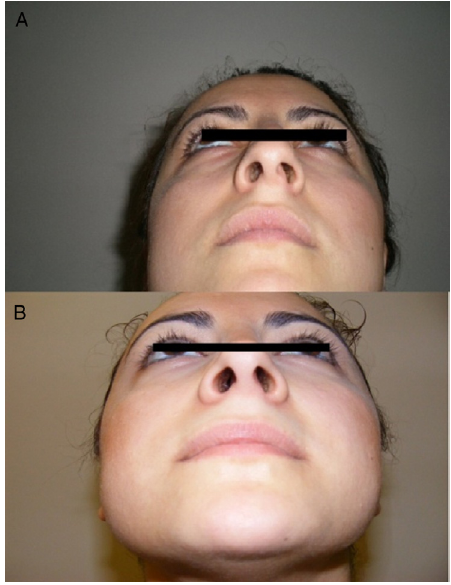
Figure 3 Preoperative and sixth month postoperative pic-